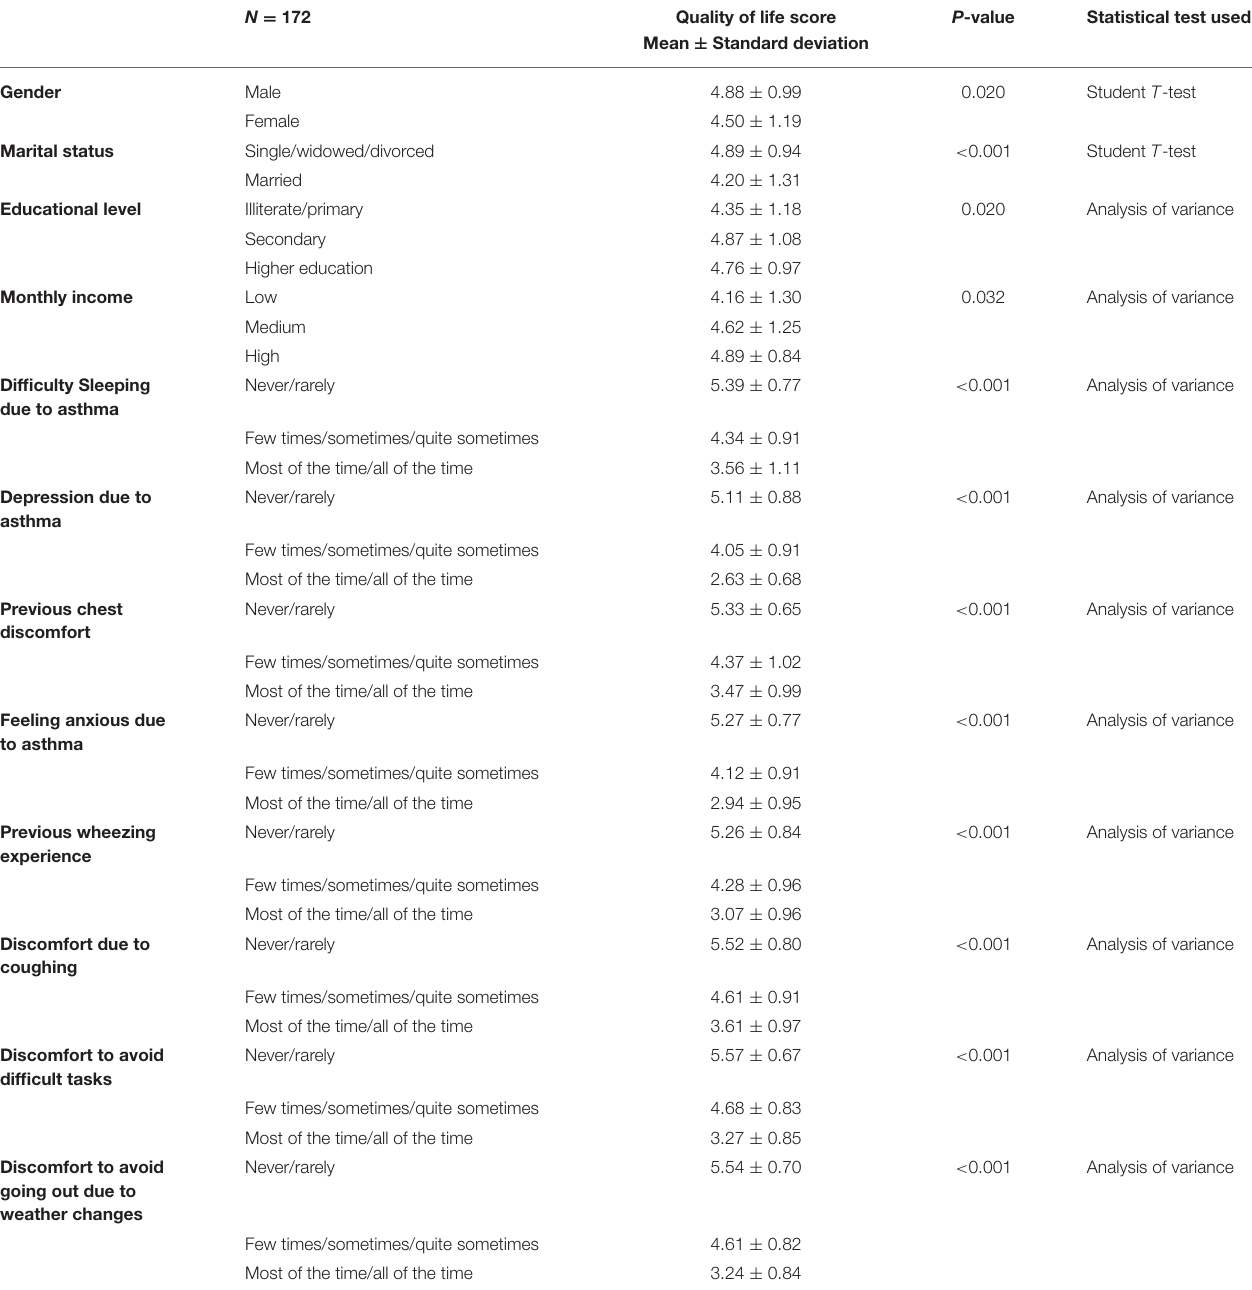
TABLE 2 | Bivariate analysis for factors associated with quality of life score. N =